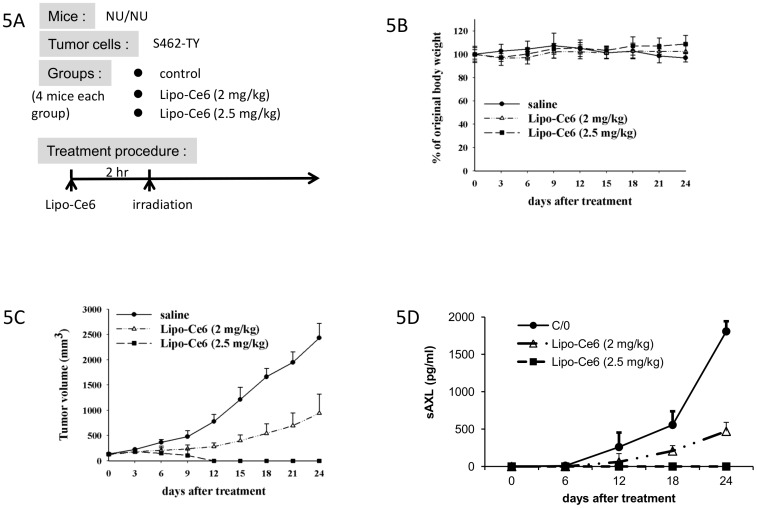
The plasma levels of human sAXL correlated to the tumor growth and the efficacy of Lipo-Ce6 in MPNST xenograft mice.
A, MPNST xenograft tumors (S462-TY) were allowed to grow until 100 mm3. Mice were injected with normal saline, 2 mg/kg or 2.5 mg/kg Lipo-Ce6 by tail vein injection. Two hours post injection mice were irradiated with a light dose of 100 J/cm2. B, treatment had no adverse effect on the body weight. C, the tumor growth was completely suppressed in the mice receiving 2.5 mg/ml of Lipo-Ce6 followed by PDT treatment and partial suppression in the mice receiving 2 mg/kg Lipo-Ce6. D, the levels of sAXL corresponded to the tumor size in all three treatment groups further supporting its role as a marker for NF1 related tumor burden.